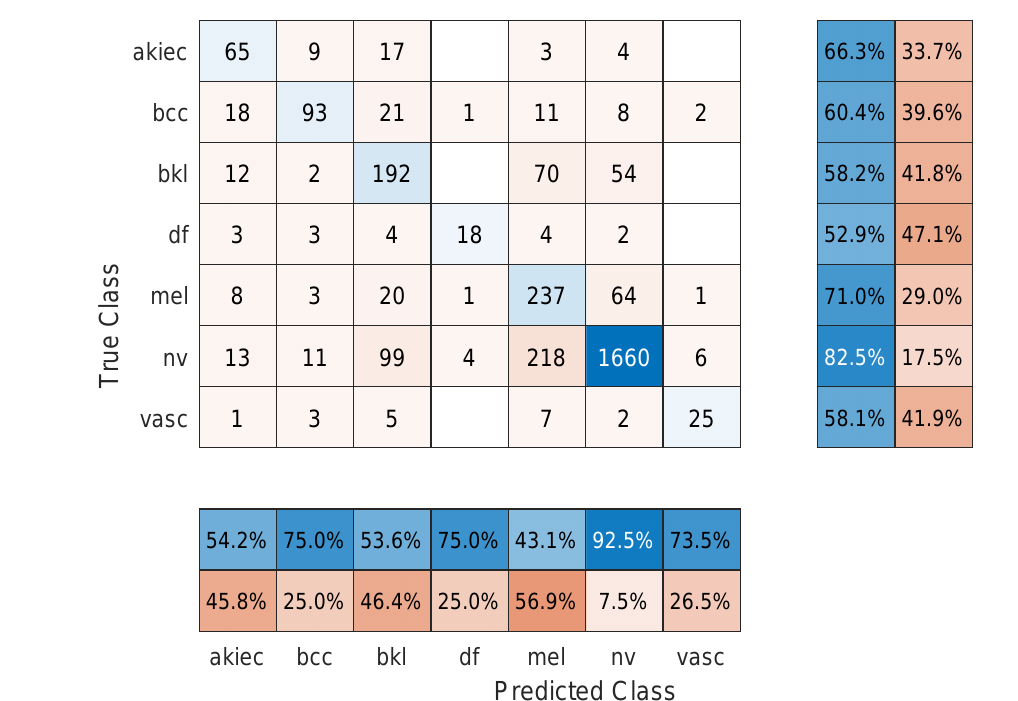
Figure 2. Sample confusion matrix for Resnet101 model and 70/30 data split.